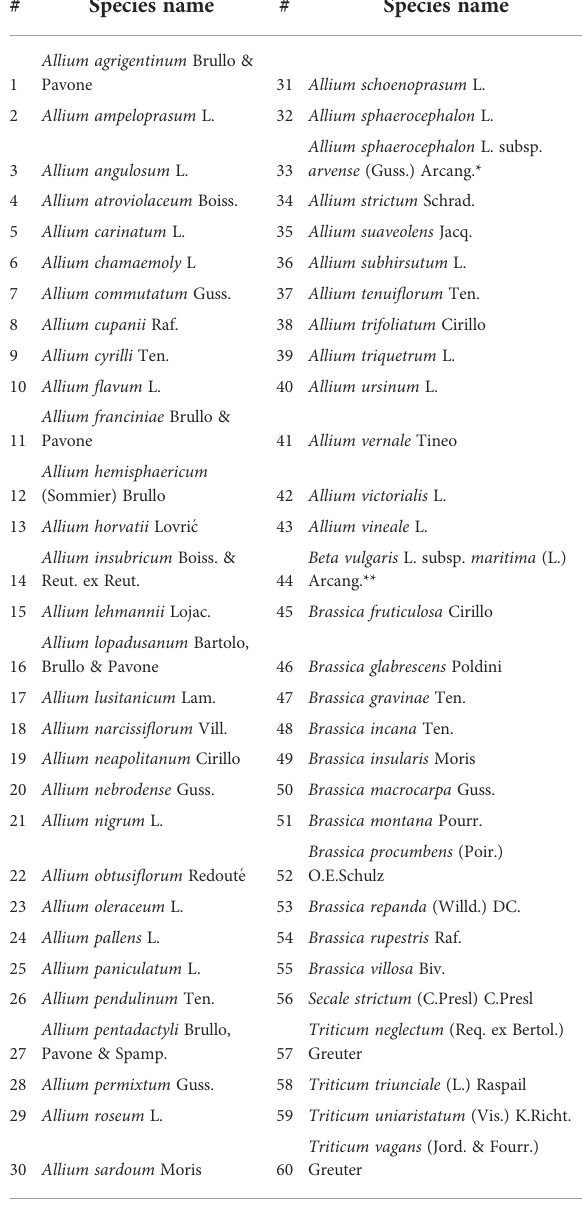
TABLE 2 List of the 60 analysed taxa ; names are listed according to the alphabetic